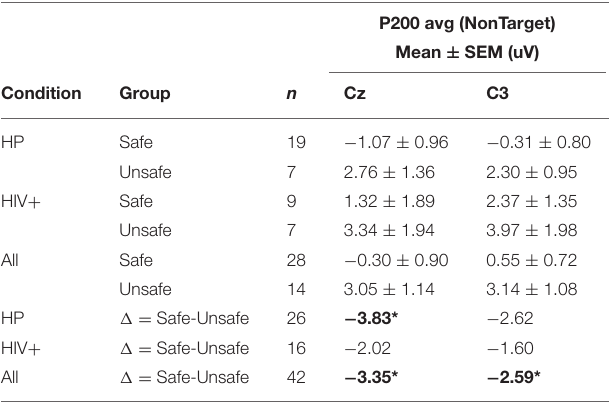
TABLE 1 | Average P200 components for all groups and subgroups based on on-road driving performance.